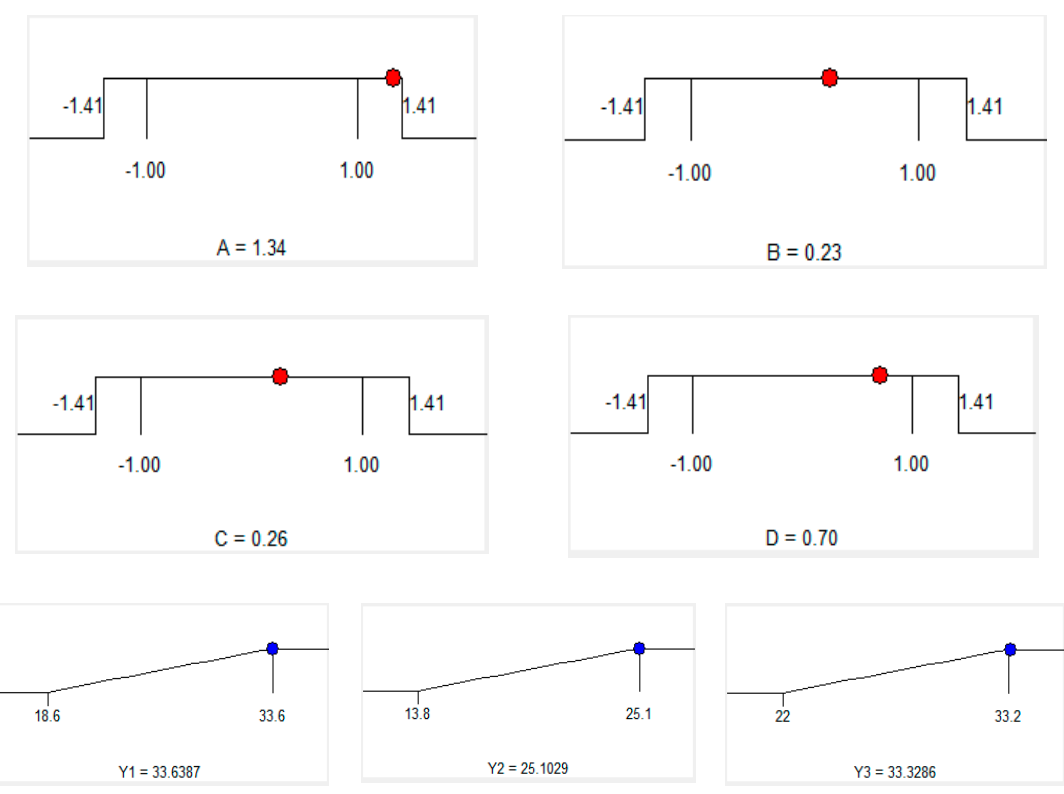
Figure 4. Optimum conditions by solution of ramps.